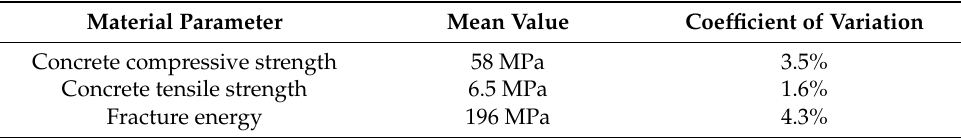
Table 3. Tested concrete material